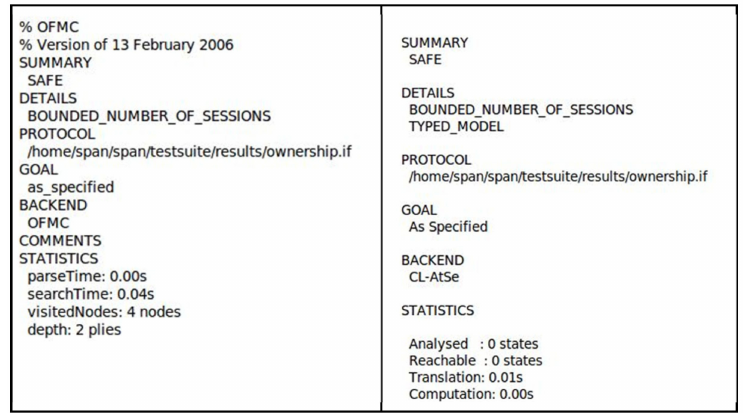
Figure 5. OFMC and CL-AtSe simulation